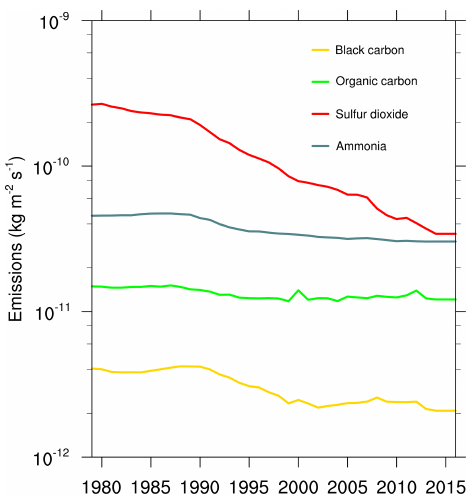
Figure 12. Yearly means of anthropogenic emissions over Europe as defined in Fig. 1 for black carbon (yellow), organic carbon (green), sulfur dioxide (red) and ammonia (blue-grey) over the pe- riod 1979–2016.